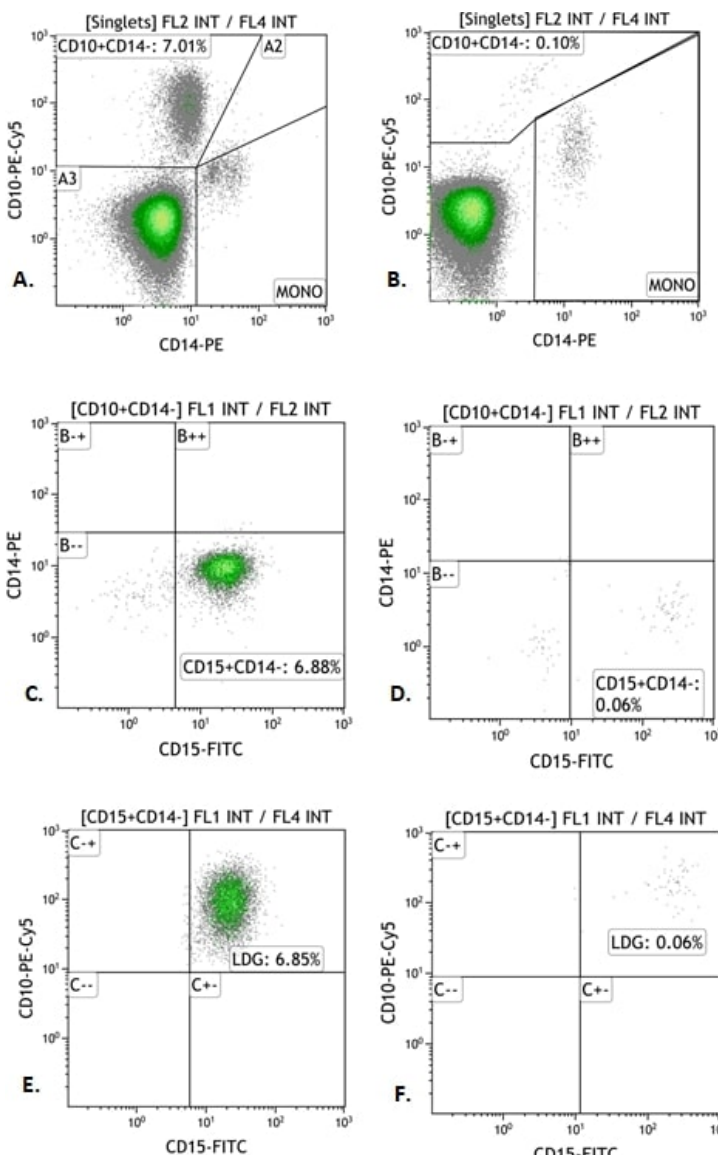
Figure 2. Exemplary Immunophenotyping of LDG (CD10+ CD15+ CD14 − ) in patients with autoimmune hepatitis (AIH) and in the control group. ( A , B ) Cytograms. Percentage of cells positive for CD10 antigen and negative for CD14 (“CD10 Gate + CD14 − ”). ( C , D ) Cytograms. Percentage of LDG positive for CD15 antigen and negative for CD14 antigen (“CD15+ CD14 − Gate”). ( E , F ) Cytograms. Percentage of LDG positive for CD15 and CD10 antigens and negative for CD14 (“LDG Gate”). ( A , C , E ) Cytograms—study group; ( B , D , F ) Cytograms—control